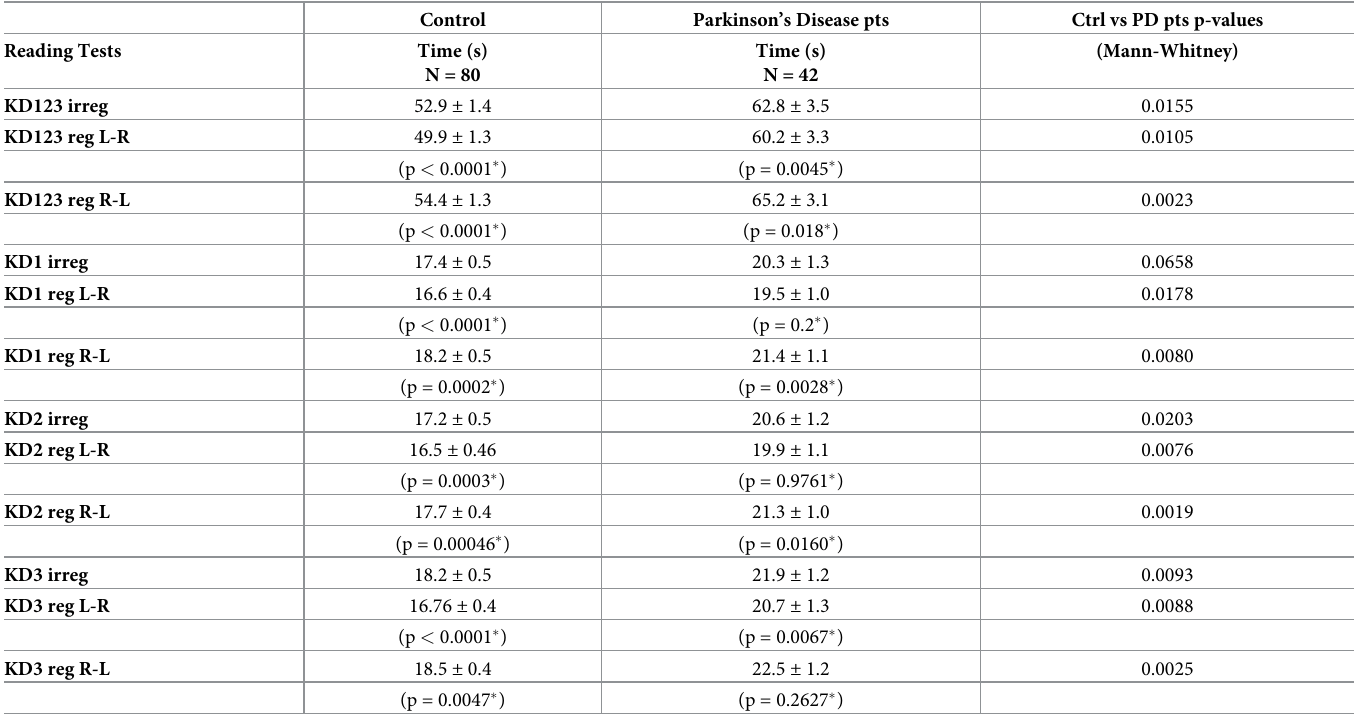
Table 1. Reading time in different number reading tests.